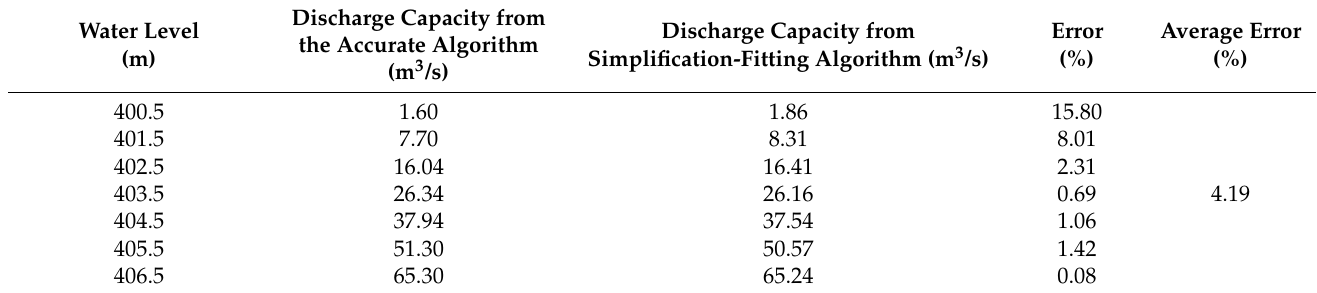
Table 2. Statistical table on errors in both simplified and accurate algorithms in the free discharge